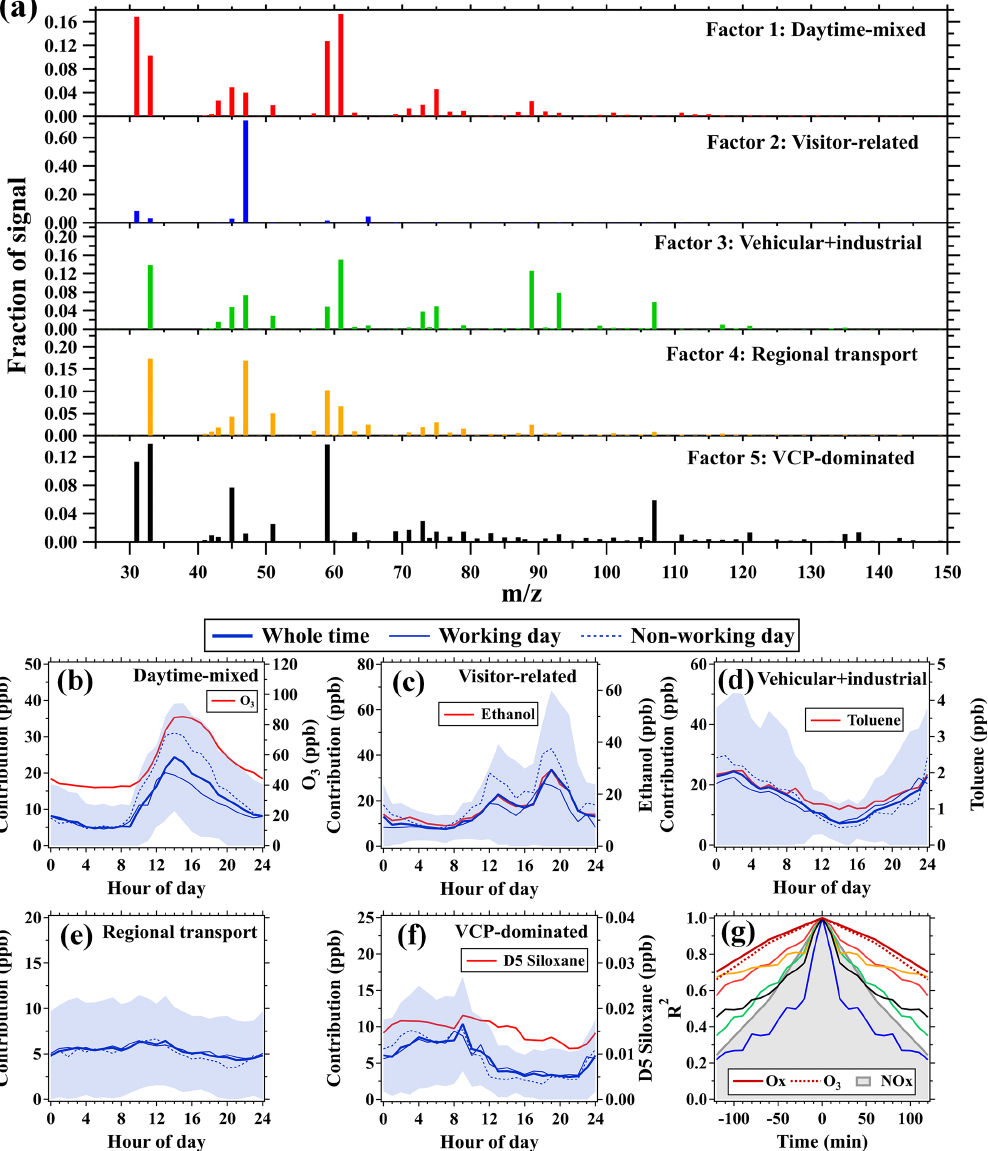
Figure 6. (a) Factor profiles ( m/z ≤ 150) of the five PMF factors; factor profiles with a full range of the mass spectra are provided in Fig. S7. (b–f) Average diurnal profiles of the five PMF factors and source tracers. (g) Autocorrelation of the time series of the five PMF factors along with O x , ozone, and NO x mixing ratios at 488m; colors of lines are consistent with the five factors in panel (a)